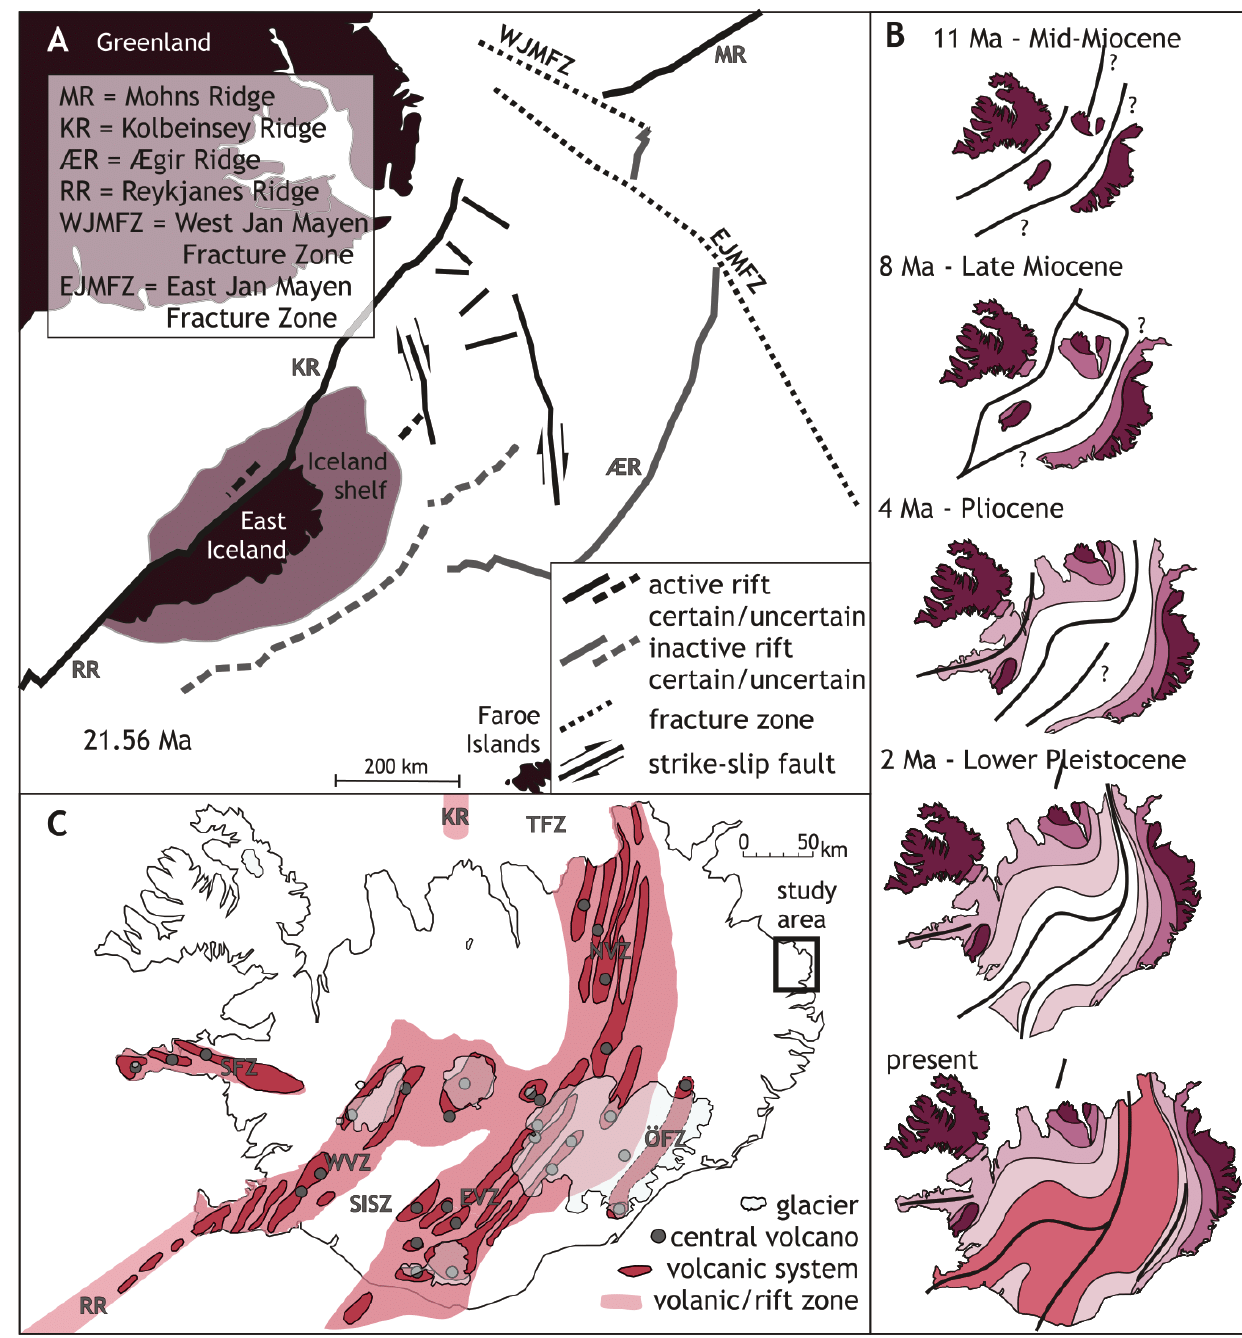
Figure 1: Geodynamic setting of Iceland through time. [A] Geodynamic setting of the North Atlantic 21.56 Ma following the transition from the Ægir to the Kolbeinsey Ridge. Modified from Blischke et al. [2016]. [B] Location of past rift zones and age of the surface rocks in Iceland. Note that little is known about the rift zone configuration in the geological past. Based on e.g. Walker [1975]. [C] Current arrangement of rift zones, flank zones, and volcanic systems in Iceland [see e.g. Sigmundsson et al.